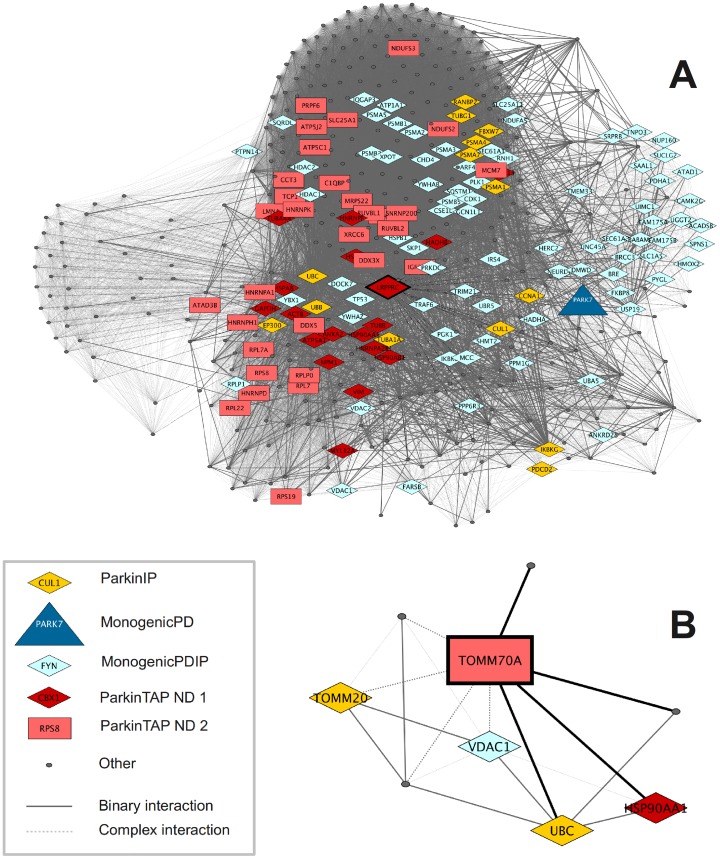
Direct protein interactions of two ParkinTAP candidates selected as exemplary proteins: LRPPRC (A) and TOMM70A (B).Proteins are represented as nodes and interactions as edges; the edges are drawn as solid and dashed lines for binary and complex interactions, respectively. Binary interactions to the selected candidates are represented by thicker edges. ParkinTAP ND X are ParkinTAP candidates at network distance X of MonogenicPD, where ParkinTAP ND 1 are direct MonogenicPD interactors. A: LRPPRC. There are many interactors of LRPPRC in iRefIndex, resulting in a dense network of complex interactions. LRPPRC interacts with MonogenicPD PARK7, as well as with 48 other ParkinTAP candidates, and the network includes 14 ParkinIP and 77 MonogenicPDIP. B: TOMM70A. Only eight proteins interact directly with TOMM70A, including one ParkinTAP candidate (HSP90AA1), two ParkinIP (TOMM20, UBC) and one MonogenicPDIP (VDAC1).